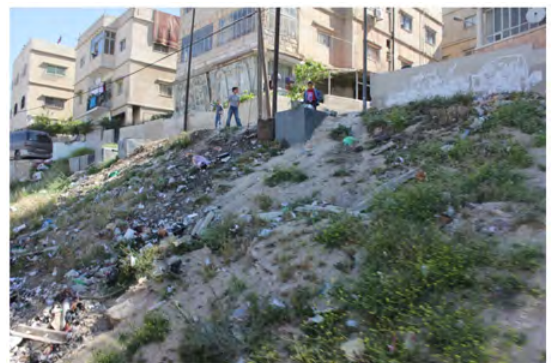
Figure 6. Examples of Fadlih ’s, Nutfih ’s and Arasah ’s 2. Source: Author (2015)